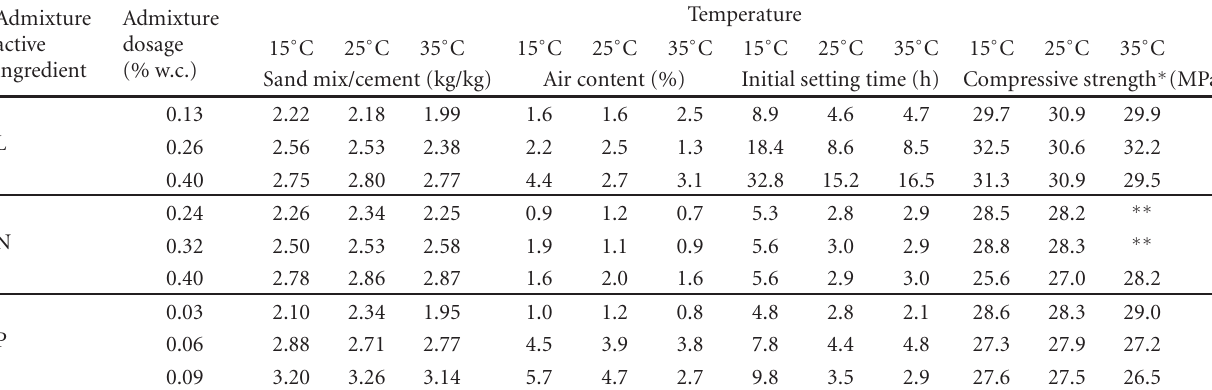
Table 2: Test results.